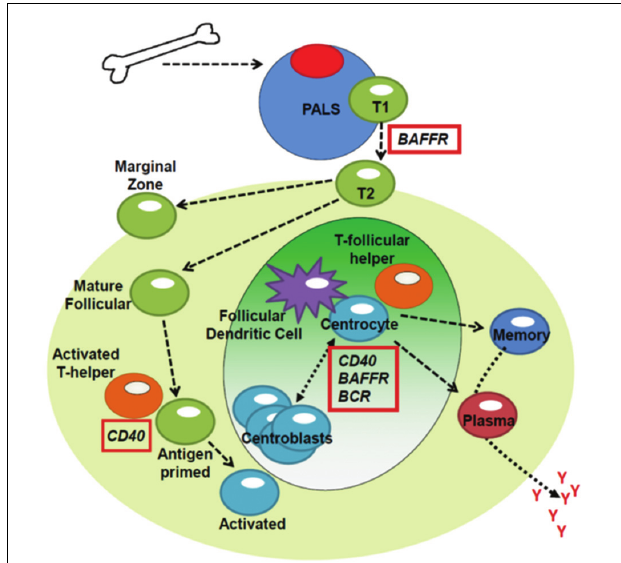
FIGURE 4 | Role of NF- κ B signaling in B cell maturation and differentiation. B cells exit the bone marrow and home to secondary lymphoid organs. The B cell exits from the arteriole into the peripheral arteriole lymphoid sheath (PALS) as a T1 B cell. Here, the B cell requires BAFF signaling to survive and mature to a T2 B cell. The T2 B cell can mature to a marginal zone B cell or follicular B cell. The mature follicular B cell can be activated by the detection of cognate antigen and CD40 costimulation. The activated B cell enters the germinal center, where it competes for antigen and costimulatory factors presented on follicular dendritic cells and produced by T follicular helper cells. Strong antigen binding and receipt of costimulatory NF- κ B-dependent signaling through CD40 and BAFF allows the B cell to mature into a memory B cell or a plasma cell.